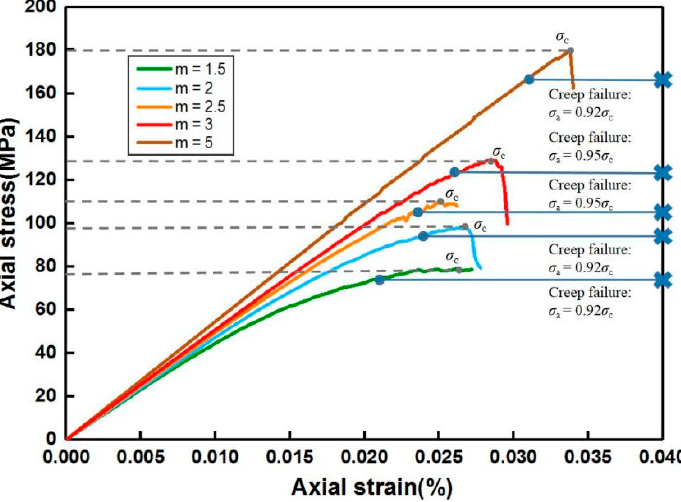
Figure 6. Uniaxial compressive simulation results for various homogeneity indexes.